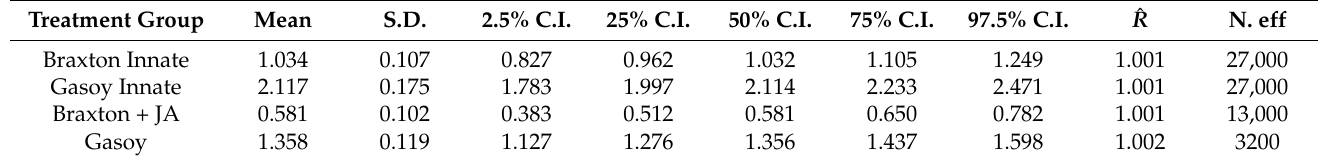
Table 1. Bayesian GLM with group means parameterization of S. frugiperda mortality at 7 days across Figure 1. Probability of S . frugiperda 7-day survival ( y -axis) on different plant cultivars crossed different G. max cultivars crossed for innate and induced jasmonic acid plant defenses. Differences with induction treatments ( x -axis). Cultivar affected insect survival with JA induction increasing between treatment group means inferred by non-overlapping 95% Credible Intervals (C.I.). larval mortality. Estimates in the figure are displayed as violin plots, represented as a traditional